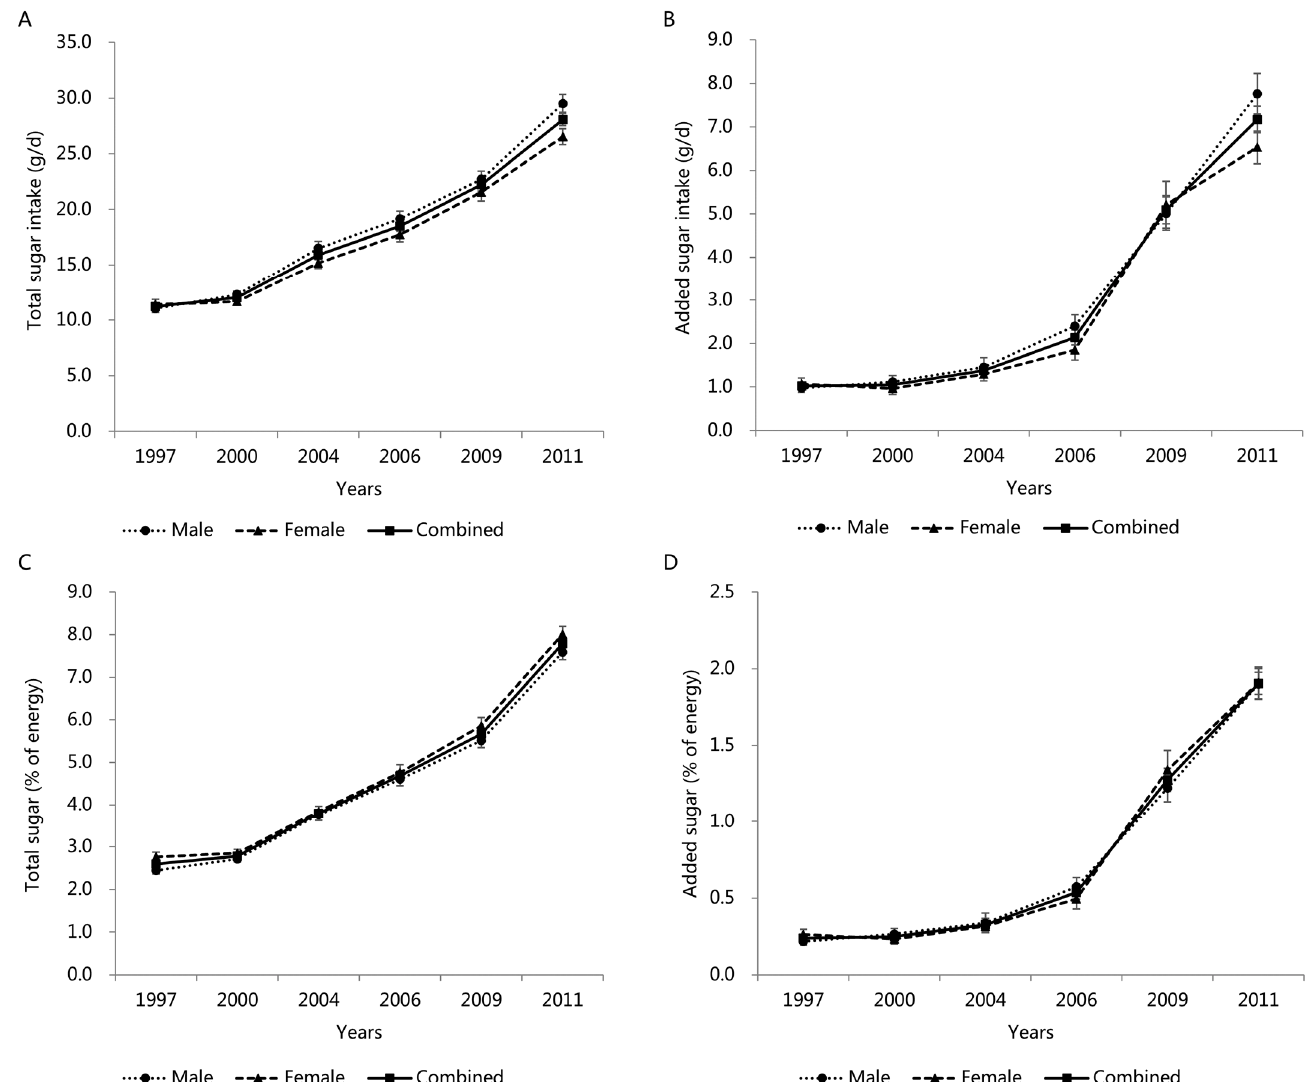
Figure 2. Mean (±SE) trends in total sugar intake ( A ), added sugar intake ( B ), total sugar (%E) ( C ), and added sugar (%E) ( D ) in Chinese children and adolescents by gender, CHNS 1997–2011. All results of linear trends by using general linear regression were p < 0.001.